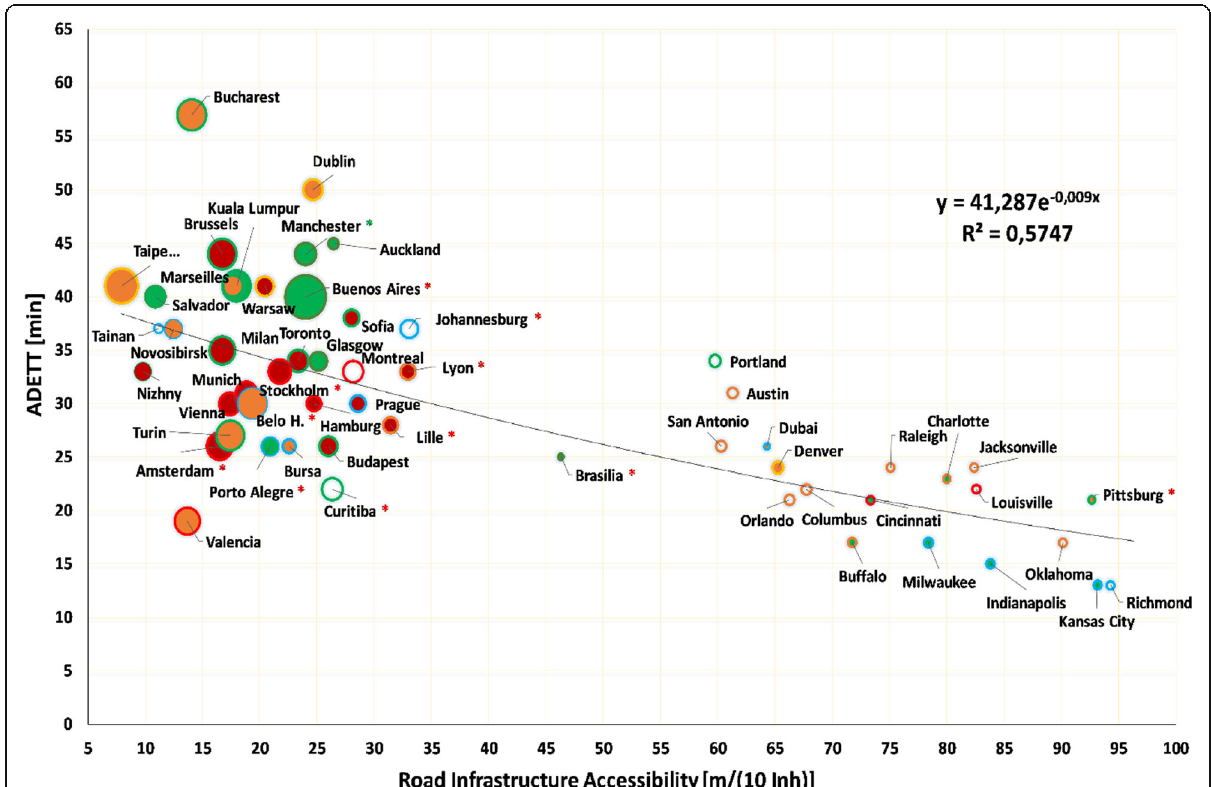
Fig. 3 Multi variant diagram of mature cities. Congestion level (ADETT) over Road IA; Bubble size is proportional to population density; filled color indicates the Train IA, bubble border color indicates Cycle IA, color of starred city- labels indicate BRT IA. For color scaling, see Table.5. The dotted line represents the fitted exponential curve from